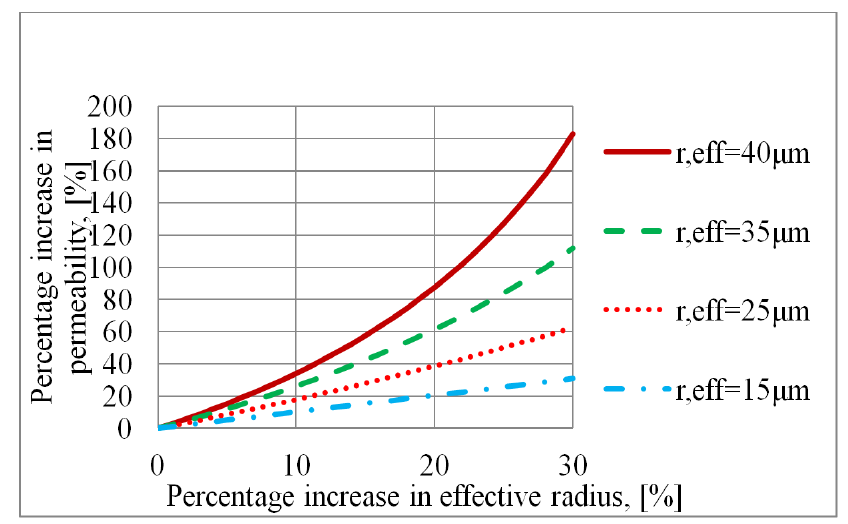
Figure 10. Pore former evaluation plot for H = 0.1 m and heptane at 20 °C.